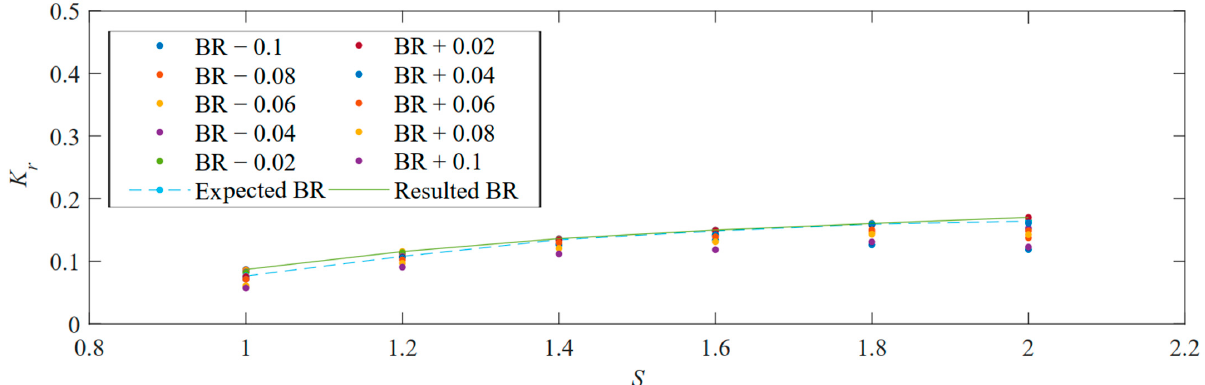
Figure 8. Bragg resonance of 2 periodically submerged breakwaters along different structural wave- lengths at 0.4 m water depth. lengths at 0.4 m water